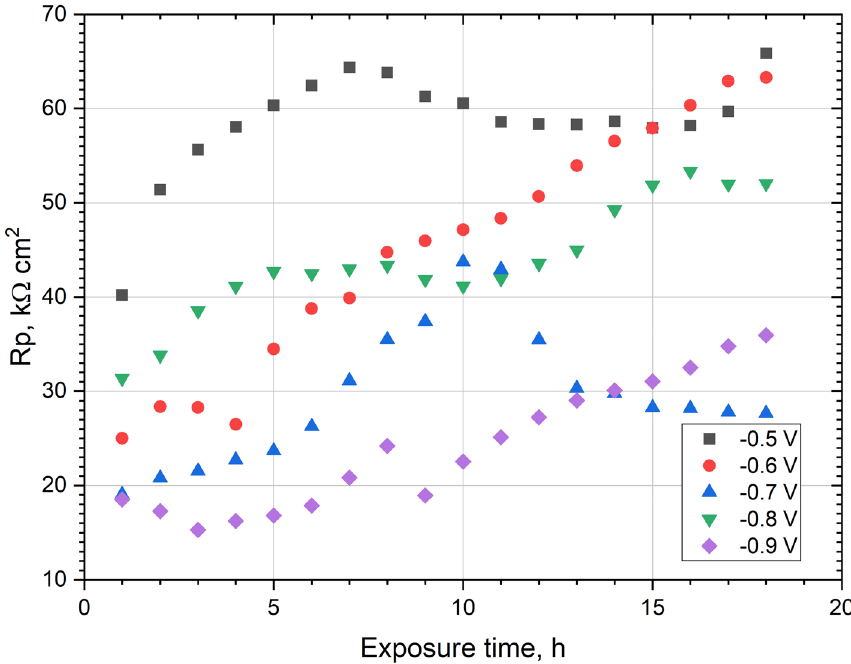
Figure 9. Polarization resistance (R p ) recorded during 18 h of exposure in 0.05 mol dm −3 deaerated NaCl solution of Ni–Mo coatings.